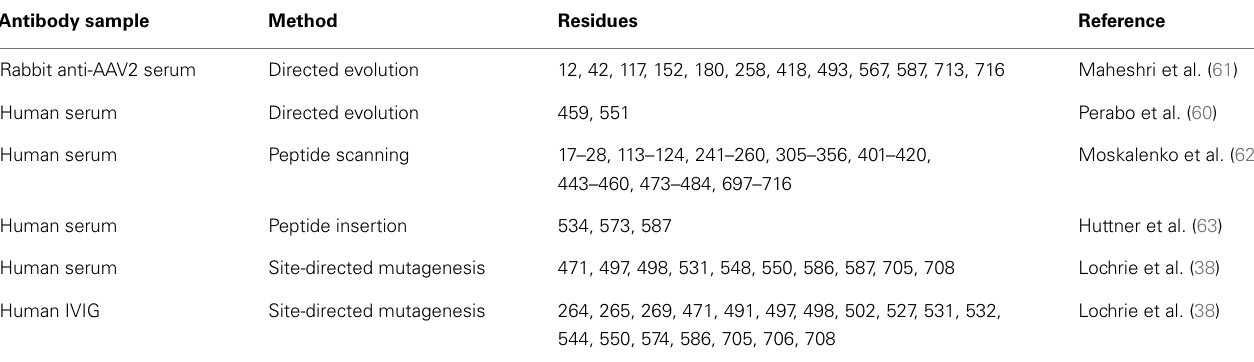
Table 1 |Antigenic sites identified by polyclonal